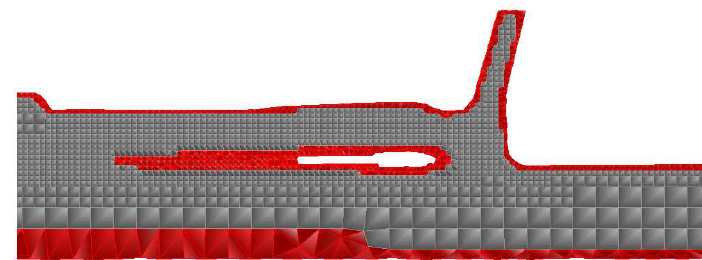
Figure 11 Hexcore Mesh Close to the Underbody